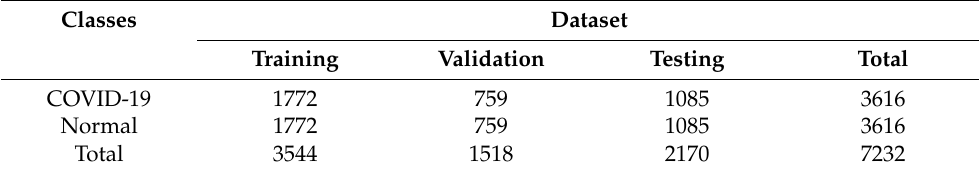
Table 1. Details of data